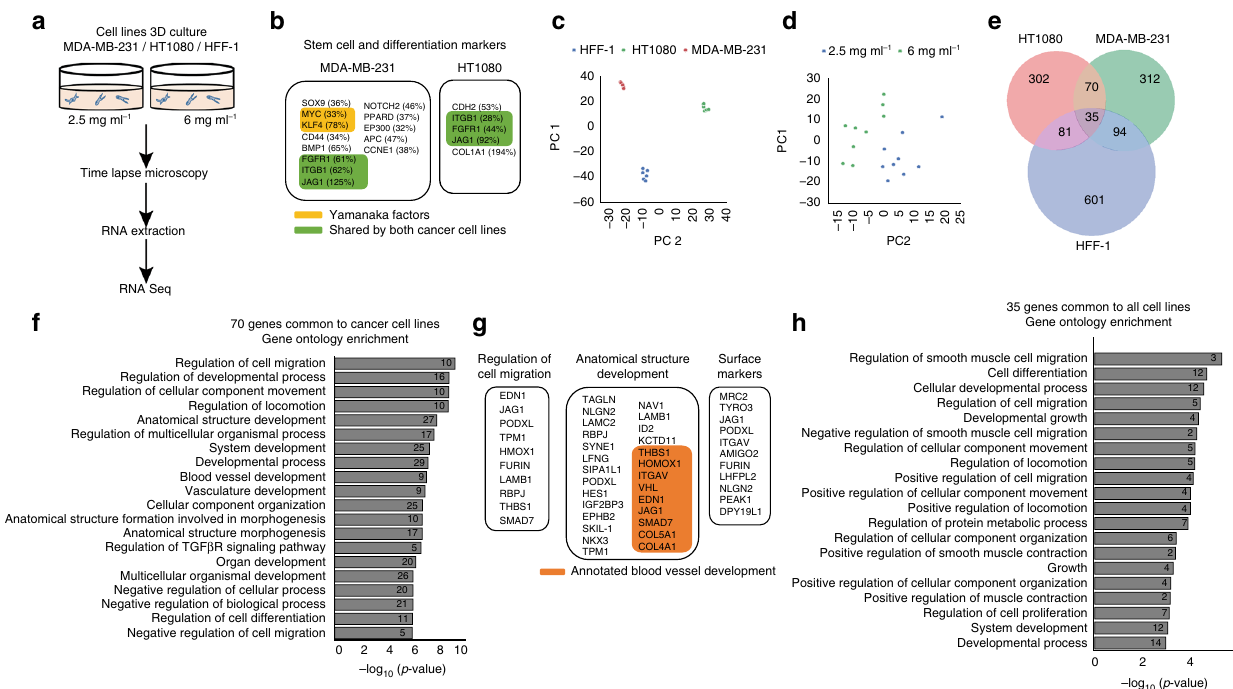
Fig. 2 The network-forming phenotype induced by high-density 3D collagen is accompanied by a transcriptional response common-to-cancer cells. a Schematic of the experimental approach. Each cell line in each condition was cultured in biological triplicate, and each replicate was sequenced ( n = 3 for each cell type per condition). b List of genes upregulated in each of the cancer cell lines that are known stem cell or differentiation markers. c Principal component analysis of raw RNA-Seq data shows cell type as main driver of variance in gene expression. d Principal component analysis of z -score transformed data shows culture condition as the main driver of variance in gene expression. e Venn diagram showing the overlap between genes upregulated in 6 vs. 2.5 mg ml − 1 collagen in the three cell lines analyzed. f Gene ontology (GO) of biological processes enriched in the 70 genes upregulated by cancer cells in 6 mg ml − 1 collagen. Number at the end of the bars represents number of genes annotated for the particular GO term. g Lists of genes with annotations relevant to the observed phenotype. Left: regulation of cell migration. Middle: regulation of anatomical structure development. Orange color highlights genes annotated for blood vessel development. Right: surfance markers. h GO of biological processes enriched in the 35 genes shared by cancer cells and HFF-1 fi broblasts. Number at the end of the bars represents number of genes annotated for the particular GO term. See “ Methods ” for analysis